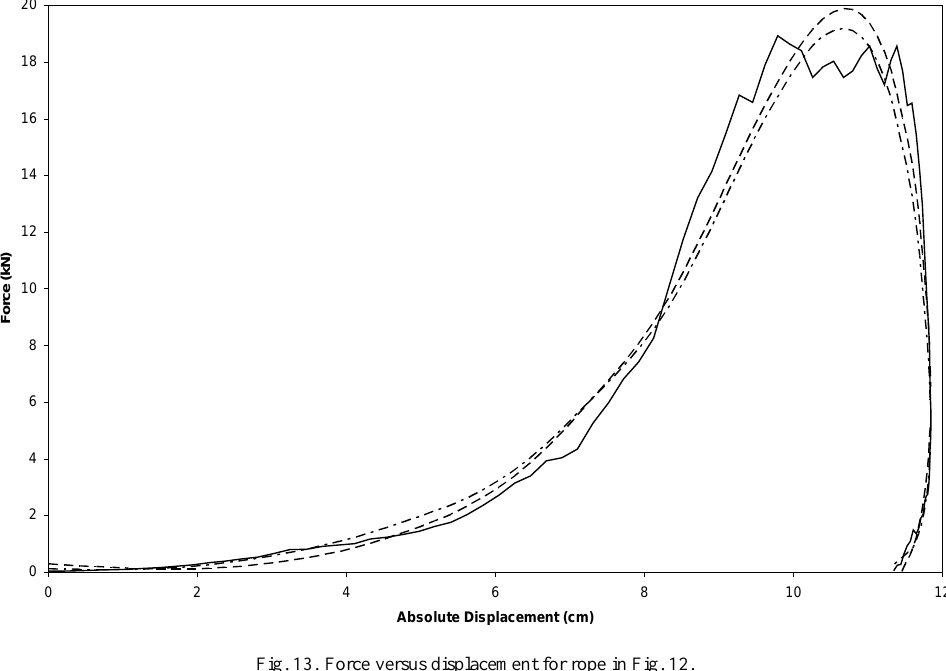
Fig. 13. Force versus displacement for rope in Fig. 12.